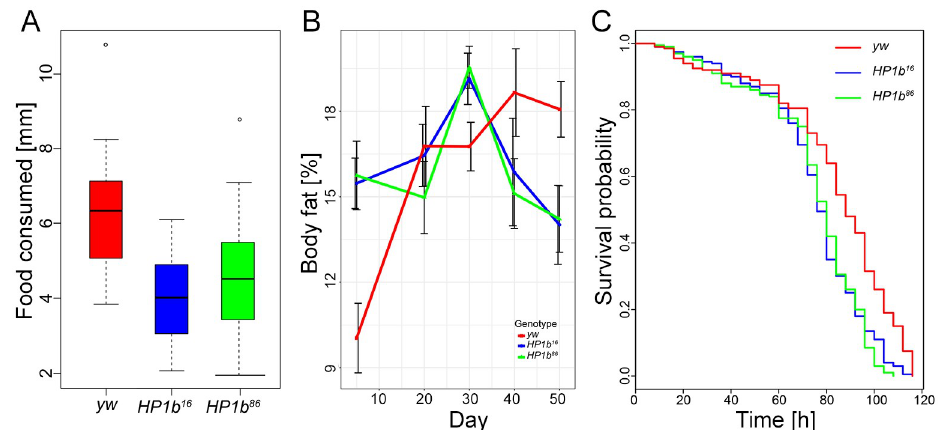
Fig 7. Loss of HP1B reduces food intake, alters body fat levels, and leads to oxidative stress resistance due to altered feeding behavior. A . Food intake measured using a CAFE´ assay (Y-axis, decrease in food levels over an 8hr time period as measured by drop in capillary meniscus in mm) reveals lower food intake in HP1b mutants ( HP1b 16 : p = 0.0003155; HP1b 86 : p = 0.0095041; Tukey’s multiple comparisons of means; n = 8 per sex and genotype). Data from one representative trial, both sexes combined are shown. For results from the additional trials and separated by sex, see S1 Table. B . Percent body fat (Y-axis) was measured by QMR in animals of different ages (X-axis). Body fat levels are increased in mutant animals early in life but decrease at a rapid rate after midlife (30–40 days). Red: yw ; blue: HP1b 16 ; green: HP1b 86 . Error bars: SD. N = 4 per sex and genotype. C . After paraquat concentration is adjusted to take into account differences in feeding behavior between HP1b mutants (blue, green) and the yw control strain (red), HP1b mutants no longer exhibit increased resistance to oxidative stress. X-axis: Time to death in hours. Y-axis: Survival probability. For separate survival curves for males and females, see S5